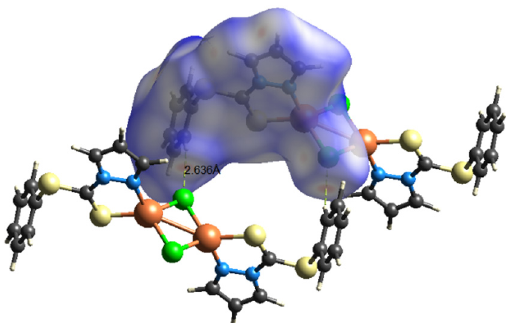
Figure 5. Visualization of the three-dimensional Hirshfeld surface of 1 mapped over d norm in the range − 0.5175 to 1.1515. Color scheme: Cu = orange; Cl: green; S = yellow; and N = blue.